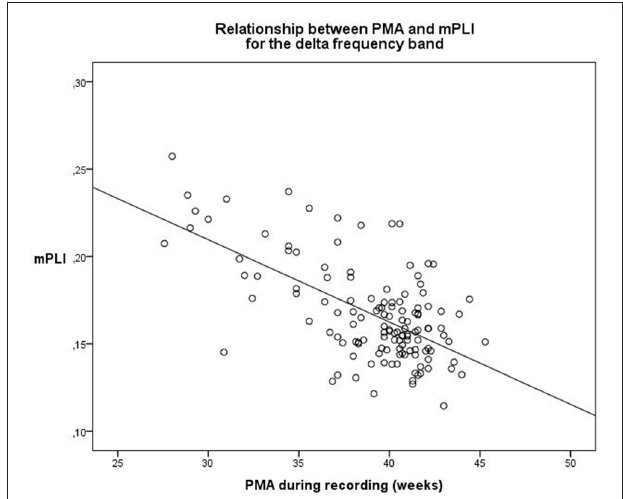
FIGURE 1 | Relationship between PMA and mPLI in the delta frequency band. The linear relationship between PMA and PLI is shown for the regression model, with B0 = 0.344 and B1 = − 0.005. Dots correspond to individual subjects ( N = 131). PMA = postmenstrual age, mPLI = mean phase lag index.